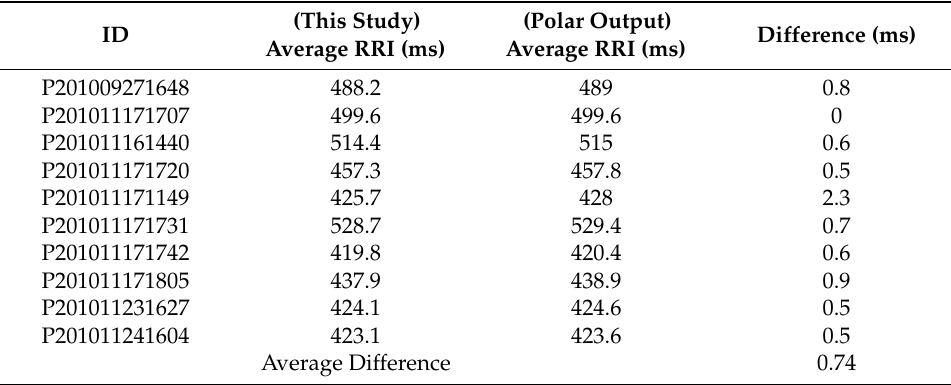
Figure 17. A sample R-R Interval curves. Table 4. The average R-R interval of 10 test cases.